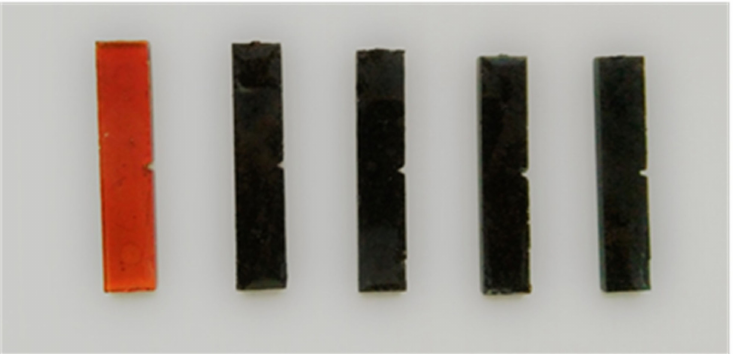
Figure 7. The test samples for the mechanical properties and impact resistance tests. Photographs from left to right are 0, 0.5, 1, 2, and 2.67 wt.% of AMG nanosheets